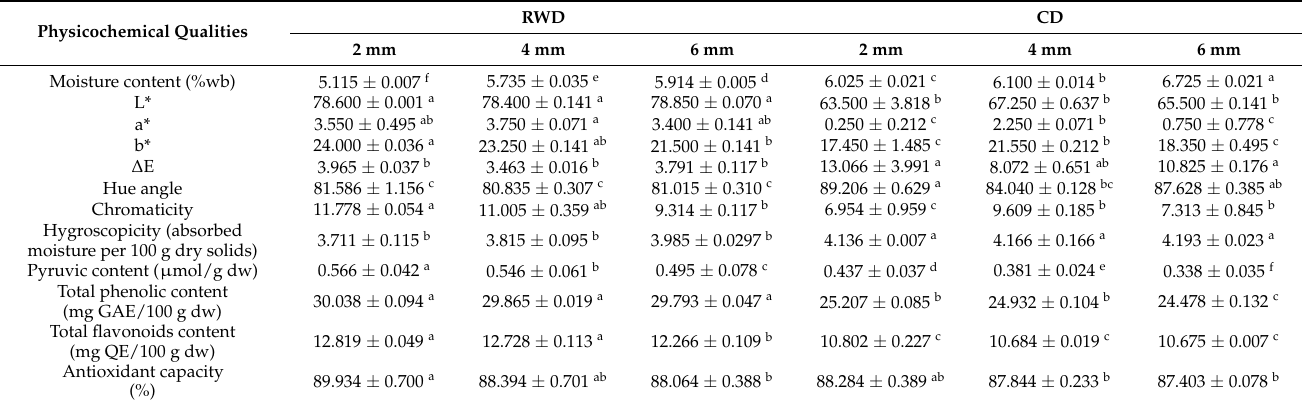
Table 5. Physicochemical qualities of RW- and convective-dried samples.